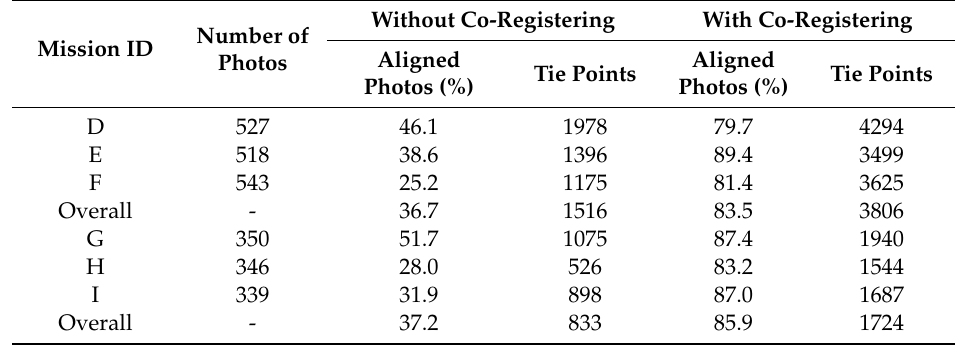
Table 5. Results from the alignment step of the orthomosaic processing with and without the use of camera positions obtained with the co-registering method.